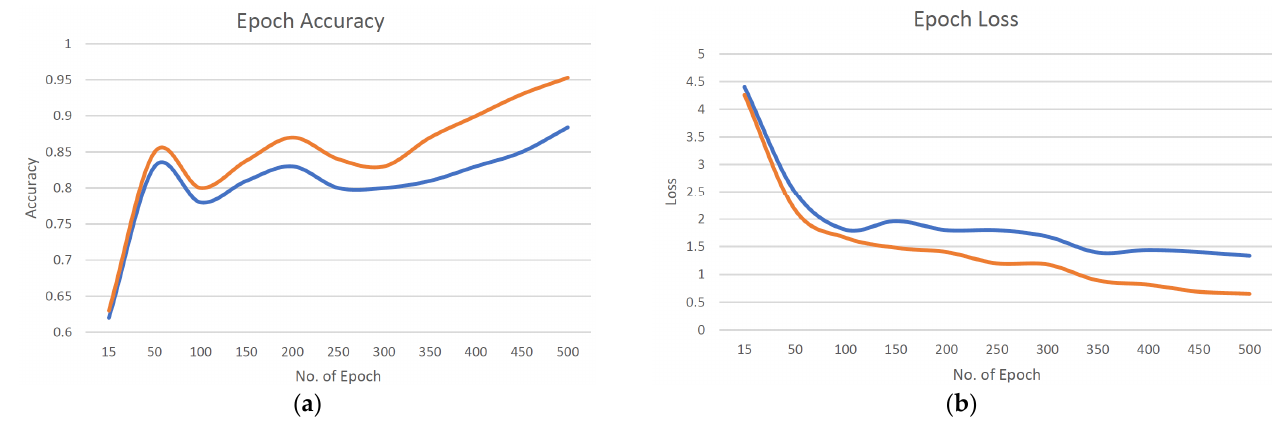
Figure 5. Epoch accuracy graph ( a ) and loss graph ( b ) of UNet (red line) and FCN-8 (blue line).